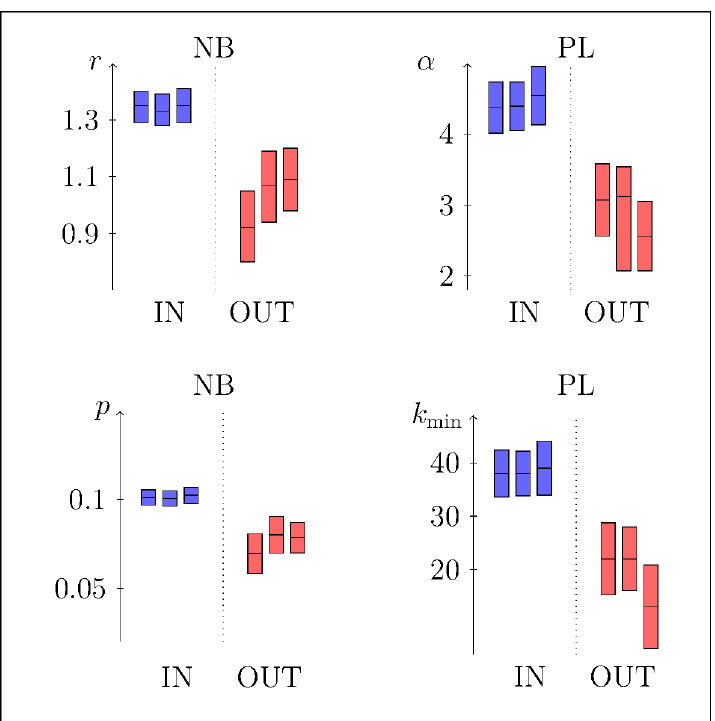
Figure 5. Estimated parameters of different distributions (NB on left and PL on right) obtained inside (blue) and outside (red) of the mice peak abundance time window. Time windows are defined by h ~ 0 : 4,0 : 5,0 : 6 (from left to right for each subsets). Vertical bars indicate best model fits (central horizontal lines) with their uncertainties that are 95% confidence interval for NB models while standard deviations for PL models.